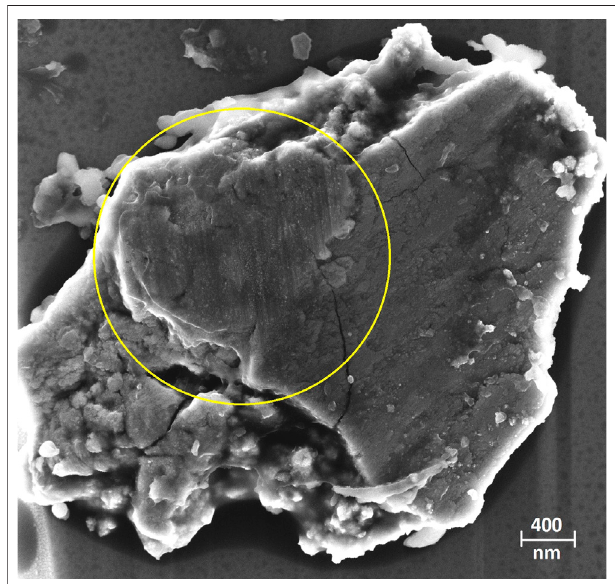
FIGURE1| SEMimageofparticleNo.4gluedtoatiplesscantilever.The SEM measurement was performed after the series of tribotests. The worn surface is marked with a yellow circle. The glue can be seen as a black region at the borders of the test